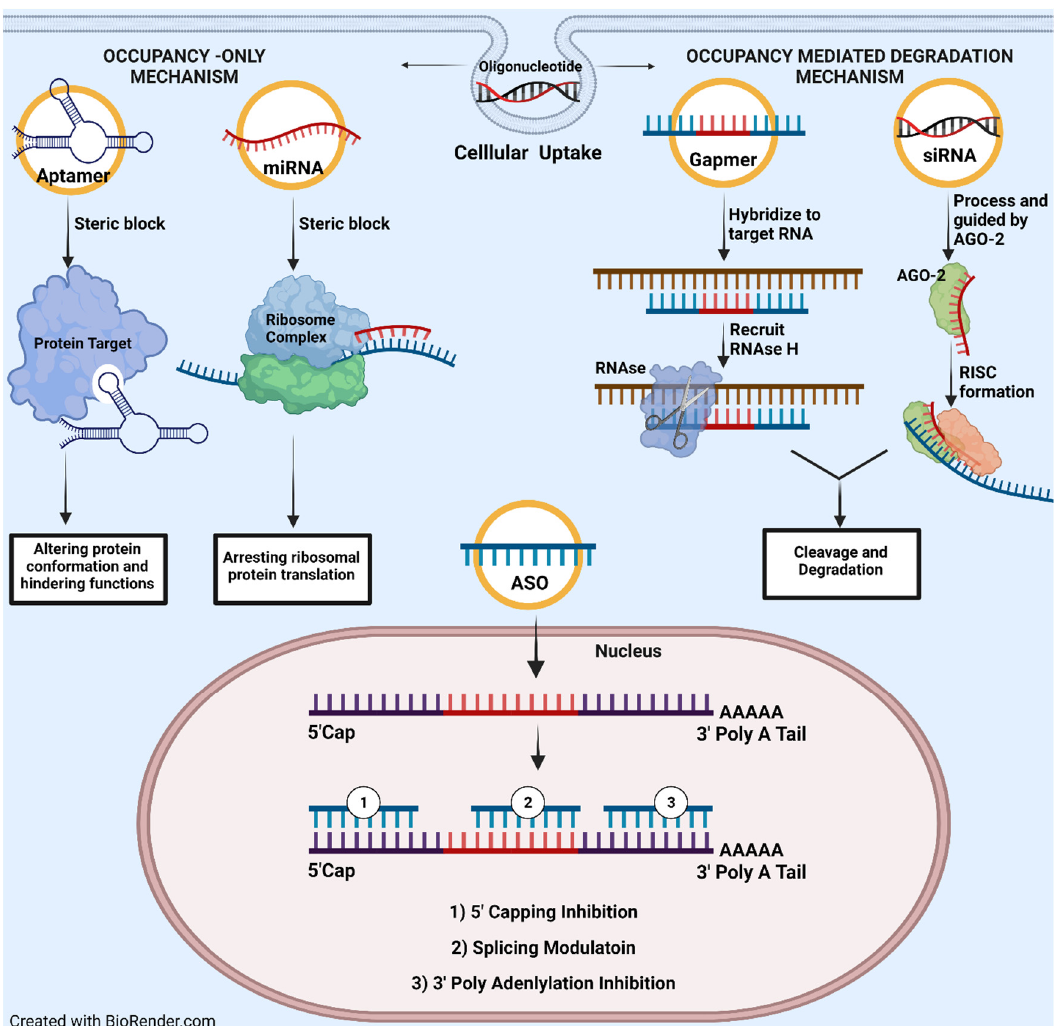
Figure 2. An illustration of main oligonucleotide mechanism of action as divided into two main groups: (1) Occupancy-only and (2) occupancy-mediated degradation. In occupancy only, oligonucleotide would act as steric blocker or inhibitor